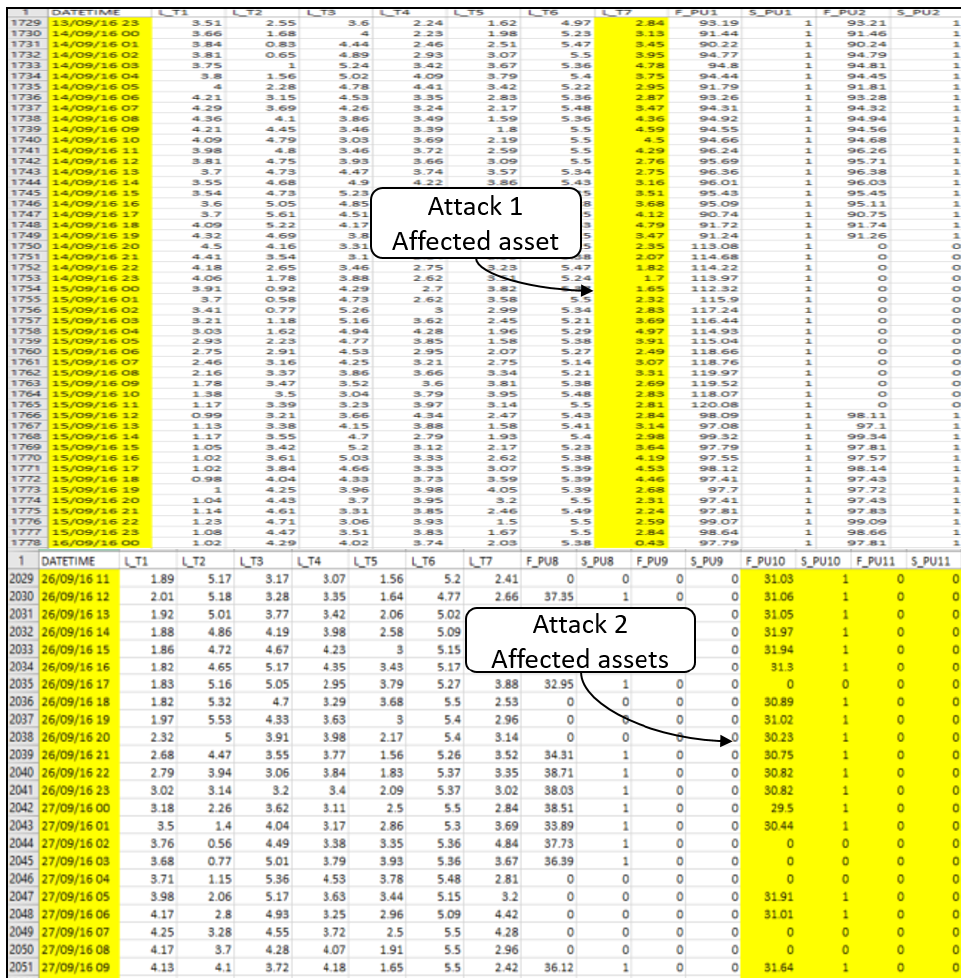
Figure 2. Two examples of attacked data in the